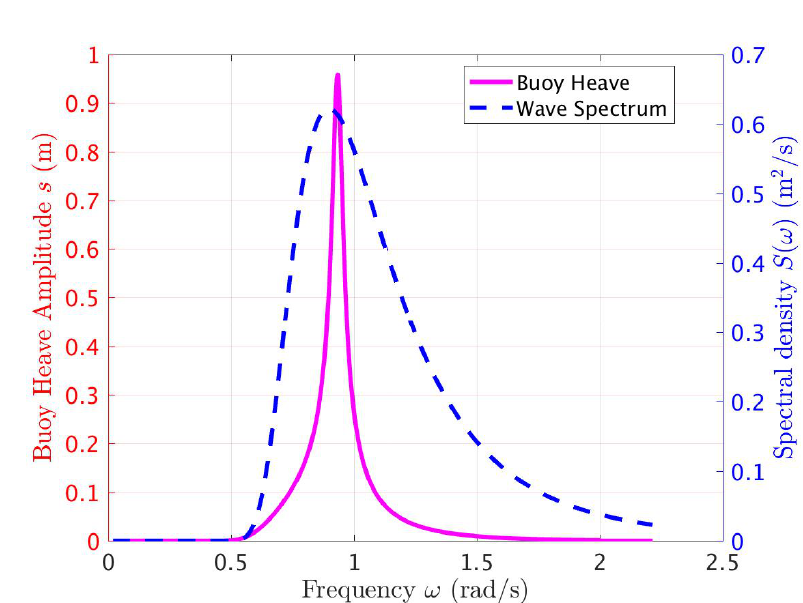
Figure 9. Buoy heave amplitude response to an irregular wave spectrum (Pierson–Moskowitz, H s = 1.0 m, T e = 5.0 s) with beams fitting loosely within their deck supports. Also shown is the power spectral density.